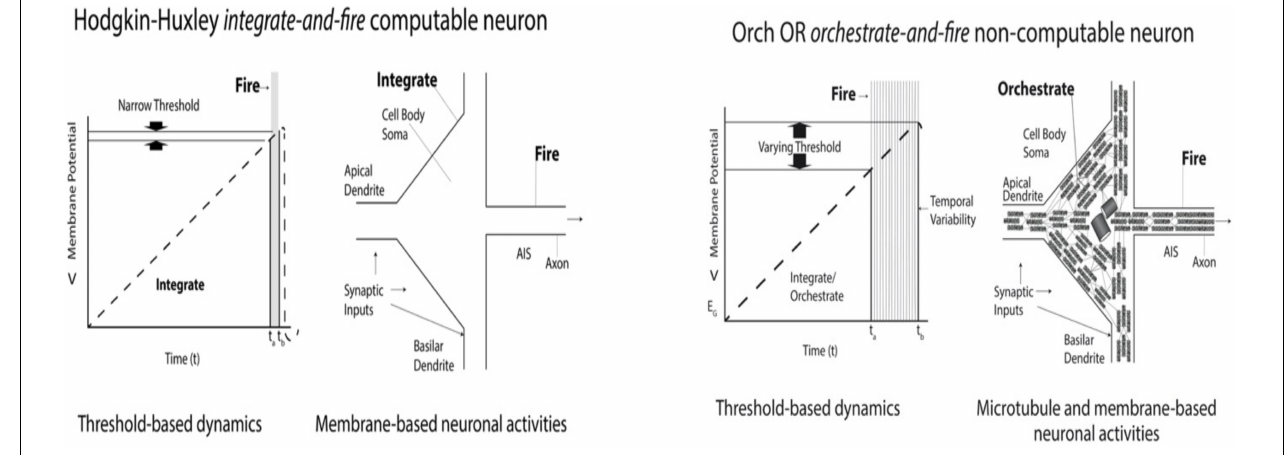
FIGURE 12 | Left: Diagram and schematic of Hodgkin-Huxley integrate-and-fire neuronal activity. Narrow threshold and temporal firing windows reflect algorithmic “computable” behavior. There is no deviation from algorithmic, Hodgkin-Huxley behavior. Next, a schematic pyramidal neuron (apex pointing left, axon to right) with only its surface membrane for algorithmic Hodgkin-Huxley behavior. Right: Recordings from cortical pyramidal neurons in awake cats show widely variable membrane potential thresholds and time windows which deviate from Hodgkin-Huxley behavior (Naundorf et al., 2006), and are thus “non-computable.” Next: Schematic of pyramidal “orchestrate-and-fire” neuron with interior mixed polarity microtubule networks, suggested in Orch OR to mediate consciousness and cause non-computable deviation from Hodgkin-Huxley behavior through variability in axonal firing threshold (interpreted from Naundorf et al.,